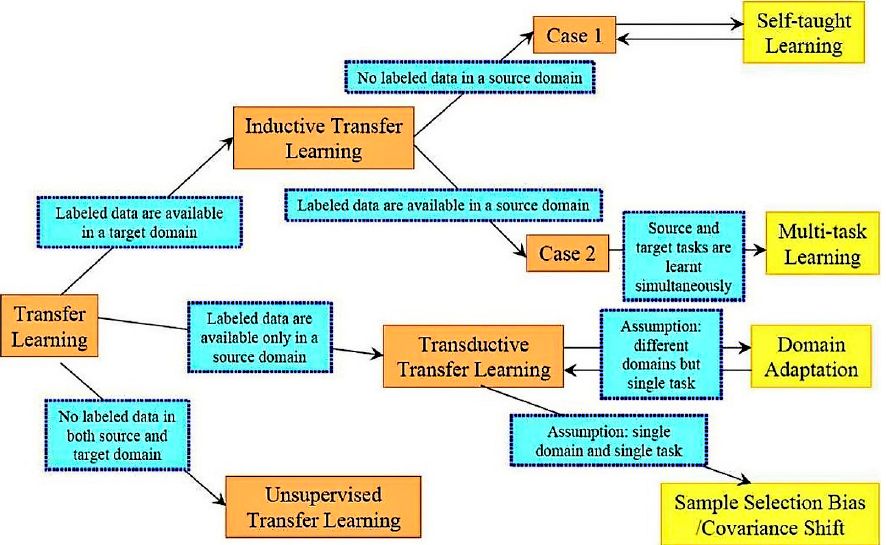
Figure 22. Different transfer learning techniques.